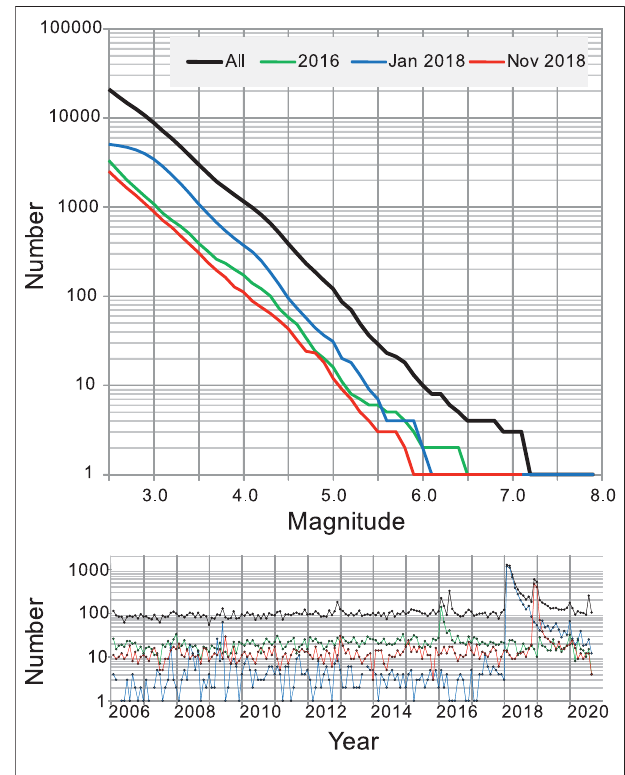
FIGURE 2 | The Gutenberg – Richter plot of the cumulative number of earthquakes (above) and the monthly number of the M ≥ 2.5 earthquakes (below) in the study region (black) and around each of the three major earthquakes: the January 24, 2016, M7.1 (green), January 23, 2018, M7.9 (blue), and November 30, 2018, M7.1 (red)